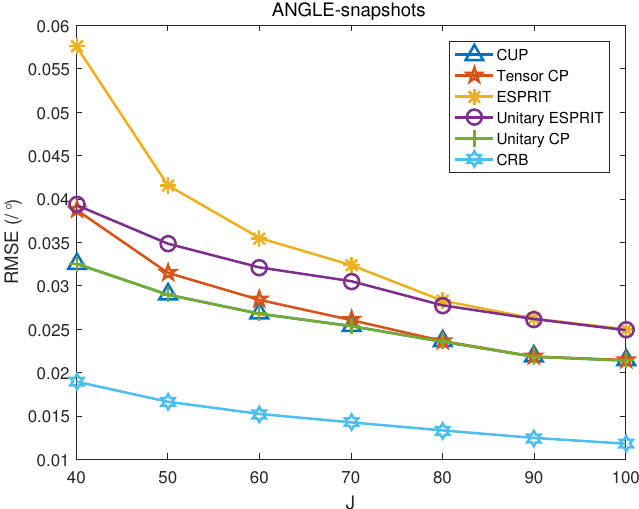
Figure 8. RMSE of angle estimation versus snapshots.